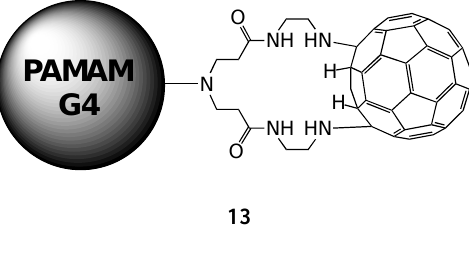
Figure 2. Proposed structure of 13 with covalently linked C polyamidoamine (PAMAM)